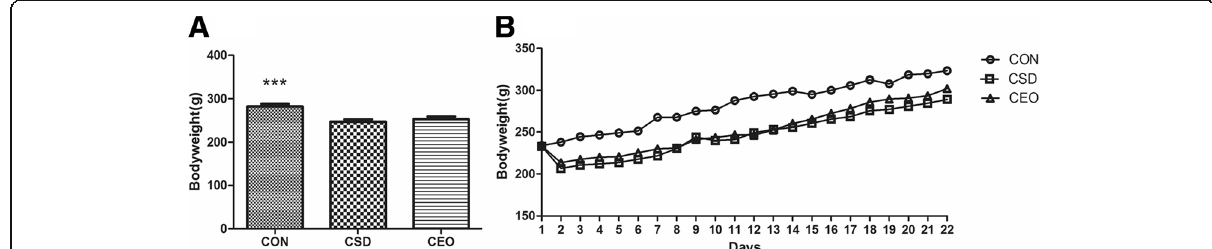
Fig. 2 Bodyweight. All data were represented as the mean ± SEM ( n = 11), ***refers to p < 0.001 vs CSD group. The bodyweight of CON rats increased significantly compared with the CSD rats ( a ). Details of daily body weight changes, as recorded at 9:00 during training days ( b ). The growth of bodyweight of CON group exhibited a higher growing trend